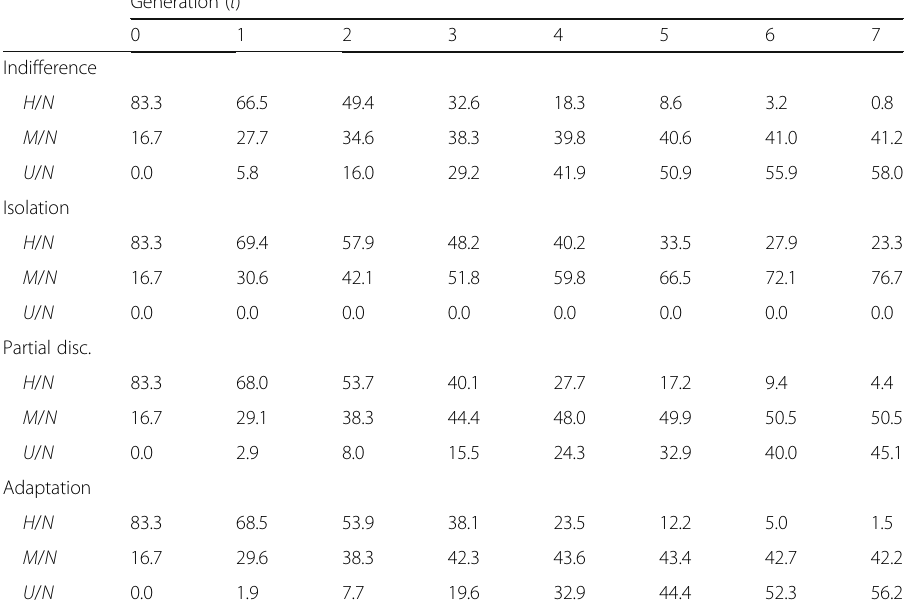
Table 5 Component populations as percent of total: alternative preference patterns with repeated immigration ( ϕ = 0.20)